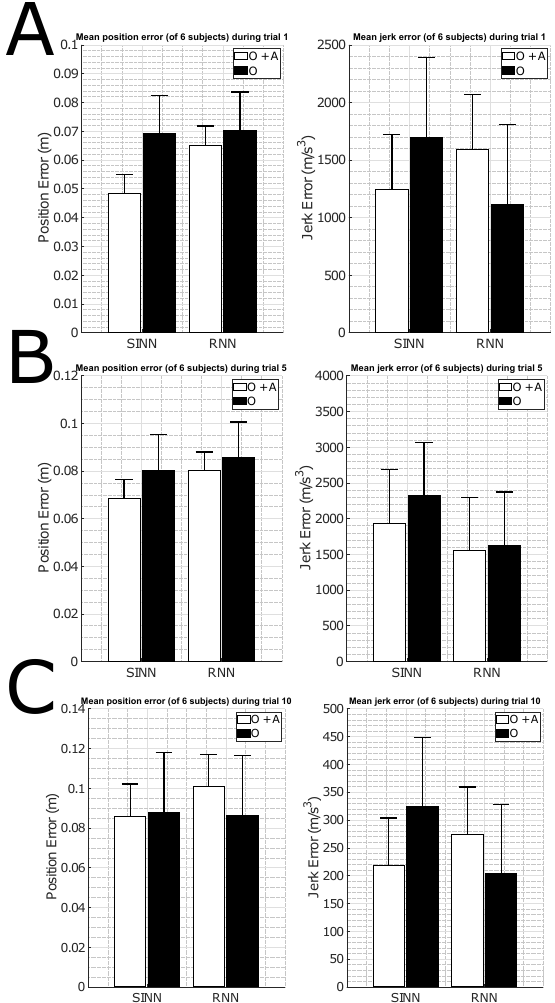
Figure 7. Bar plots of the mean (of 6 subjects) joint position and jerk error for the shallow (SINN) and deep (RNN) learning approaches (left and right, respectively) using orientation features ( O in black) and including accelerations ( O + A in white). Three different types of activities are shown namely: gait ( A ), sports ( B ) and ADL ( C ). Standard deviation over the various subjects is displayed by black whiskers. These results were obtained using the following parameters: I = 2, H = 2 and F =